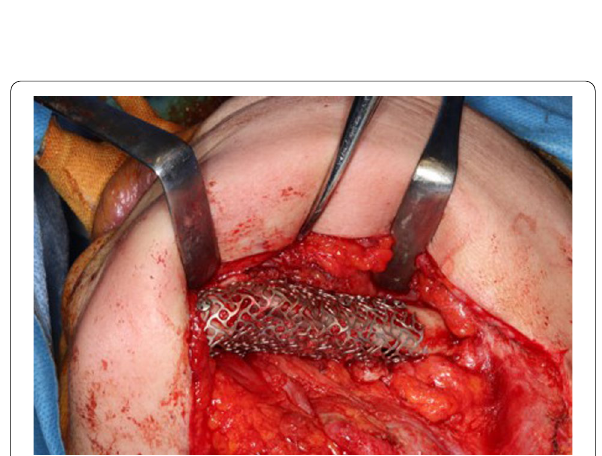
Fig. 4 Secondary reconstruction using a PCBM graft covered by a titanium mesh plate